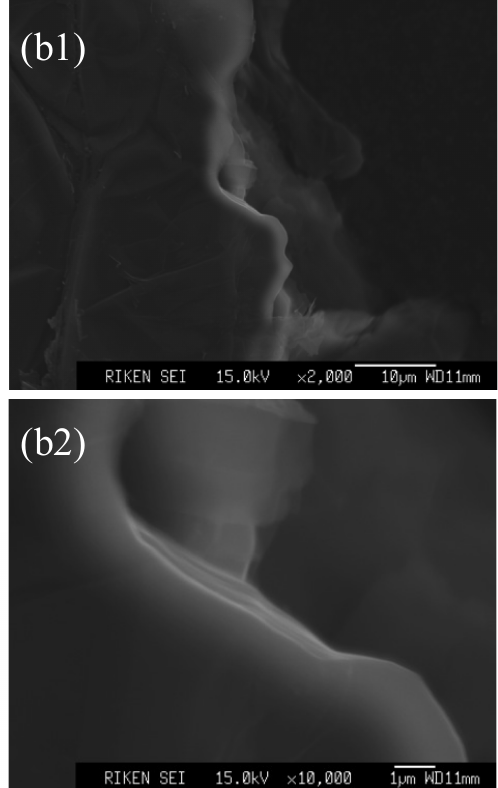
Fig. 3b. SEM images of the GS surface edge taken from above. (b1) and (b2): beam-irradiated